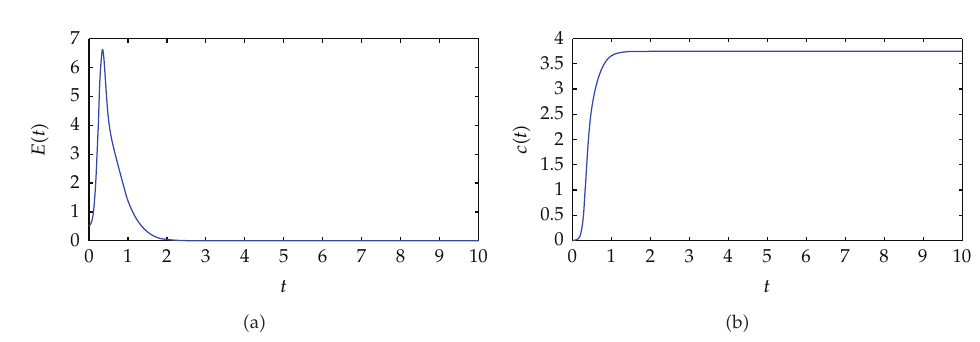
Figure 4: Adaptive adjustment of the coupling strength of a pinned Chua’s circuit